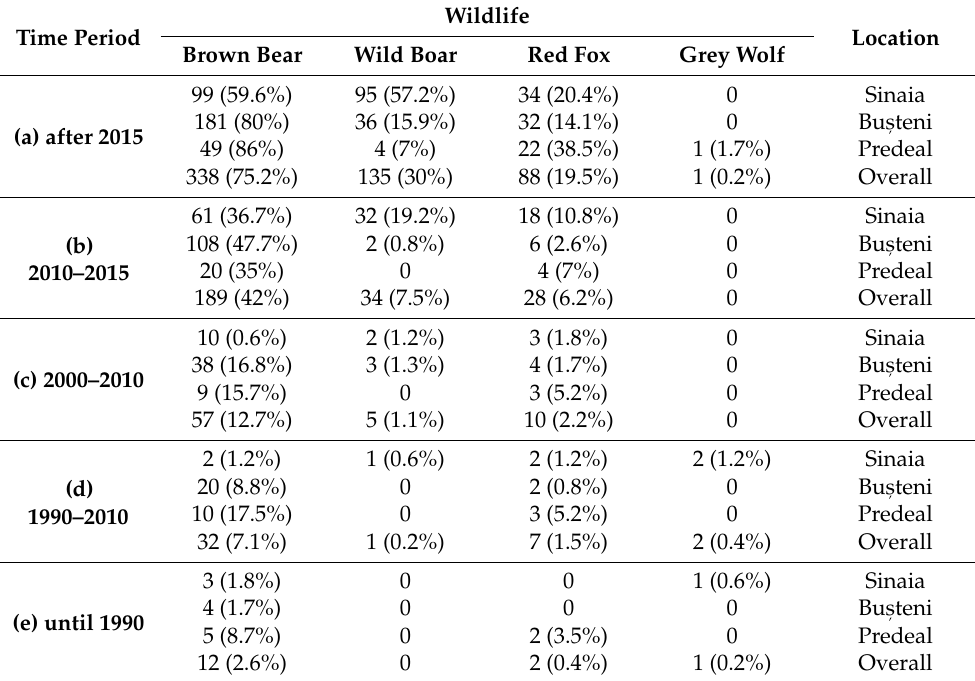
Table 3. Number (percent) of households which were engaged in HWI with a species, from the total number of households within Sinaia (166), Bucegi (226), Predeal (57) and entire Prahova Valley (449) sampling